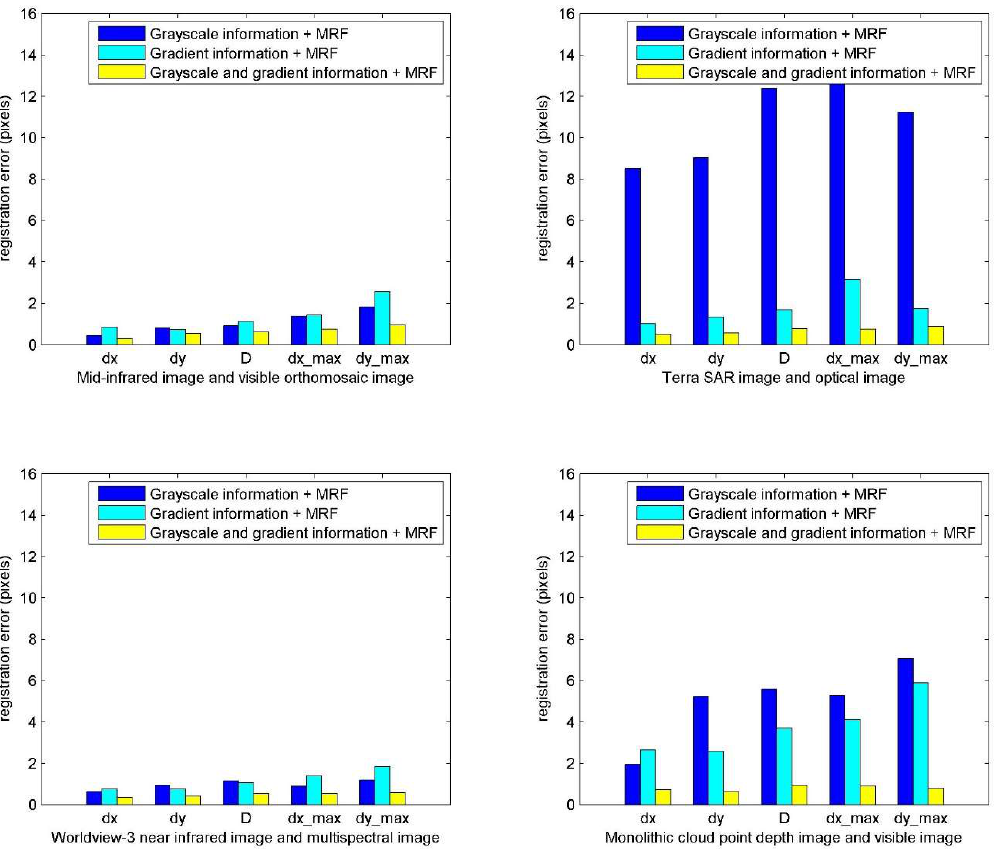
Figure 10 . Accuracy improvements from gradient information in four multimodal datasets. Figure 10. Accuracy improvements from gradient information in four multimodal